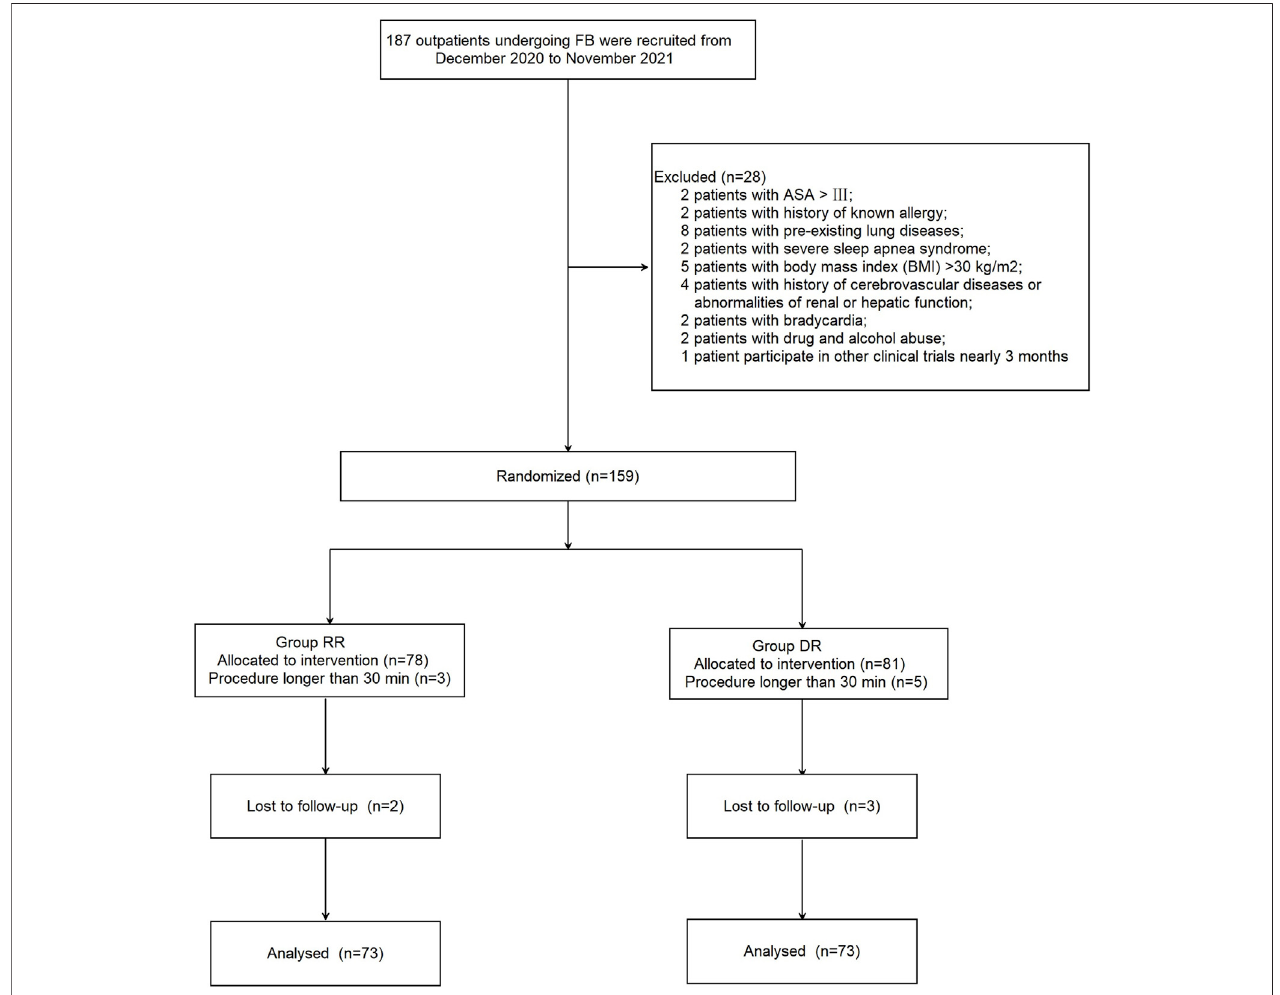
FIGURE 1 | Patient fl owchart with CONSORT